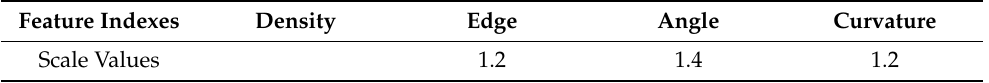
Table 2. Scale values of indexes for 3D model experiments.